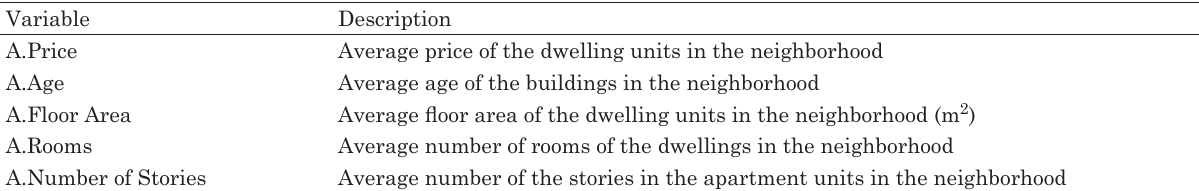
Table 2. Description of variables in cluster analysis